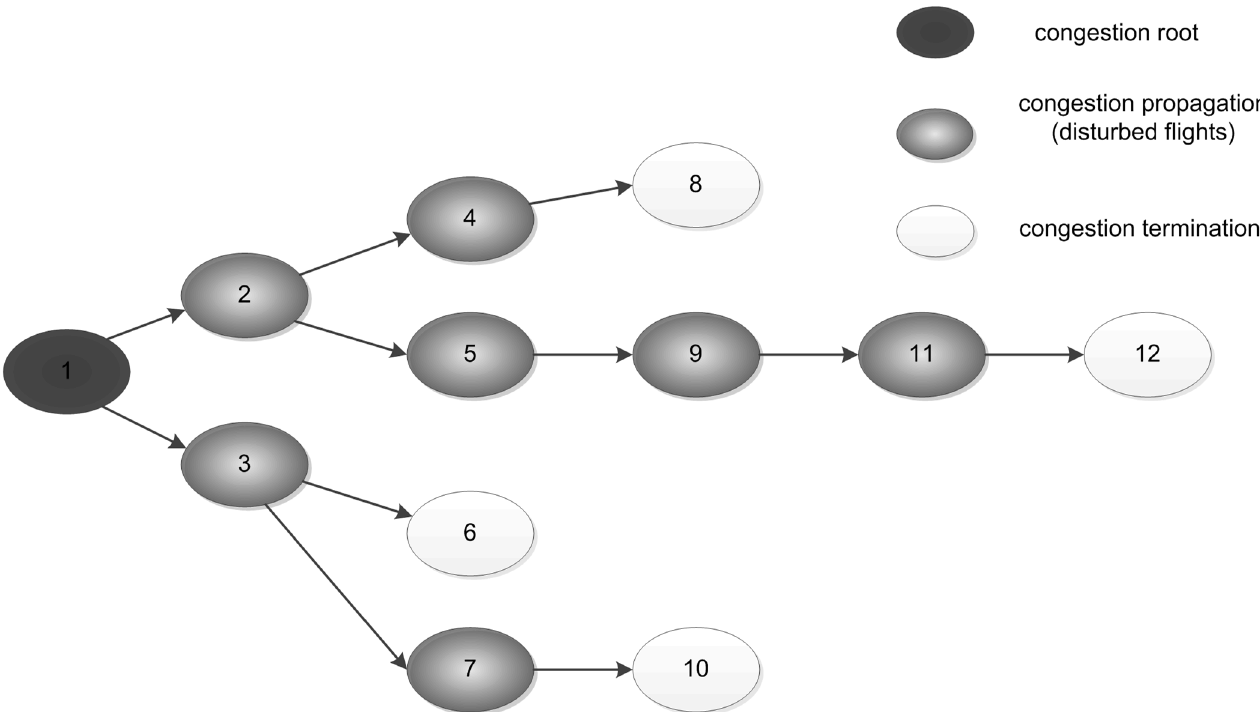
Fig 1. Congestion propagation